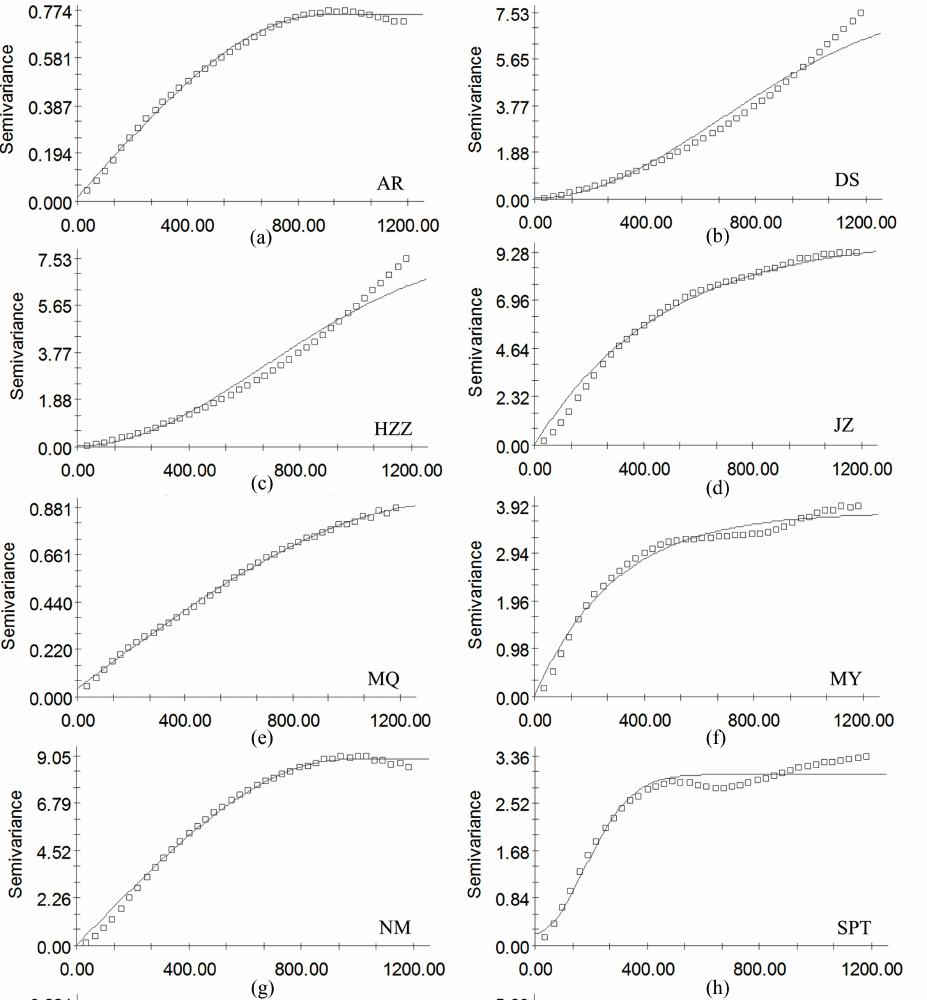
Figure 5. Variograms of all stations. ( a )AR station; ( b )DS station; ( c ) HZZ station; ( d ) JZ station; ( e ) MQ station; ( f ) MY station; ( g ) NM station; ( h ) SPT station; ( i ) TYF station; ( j ) YK station; ( k ) TYG station; ( l )YZ